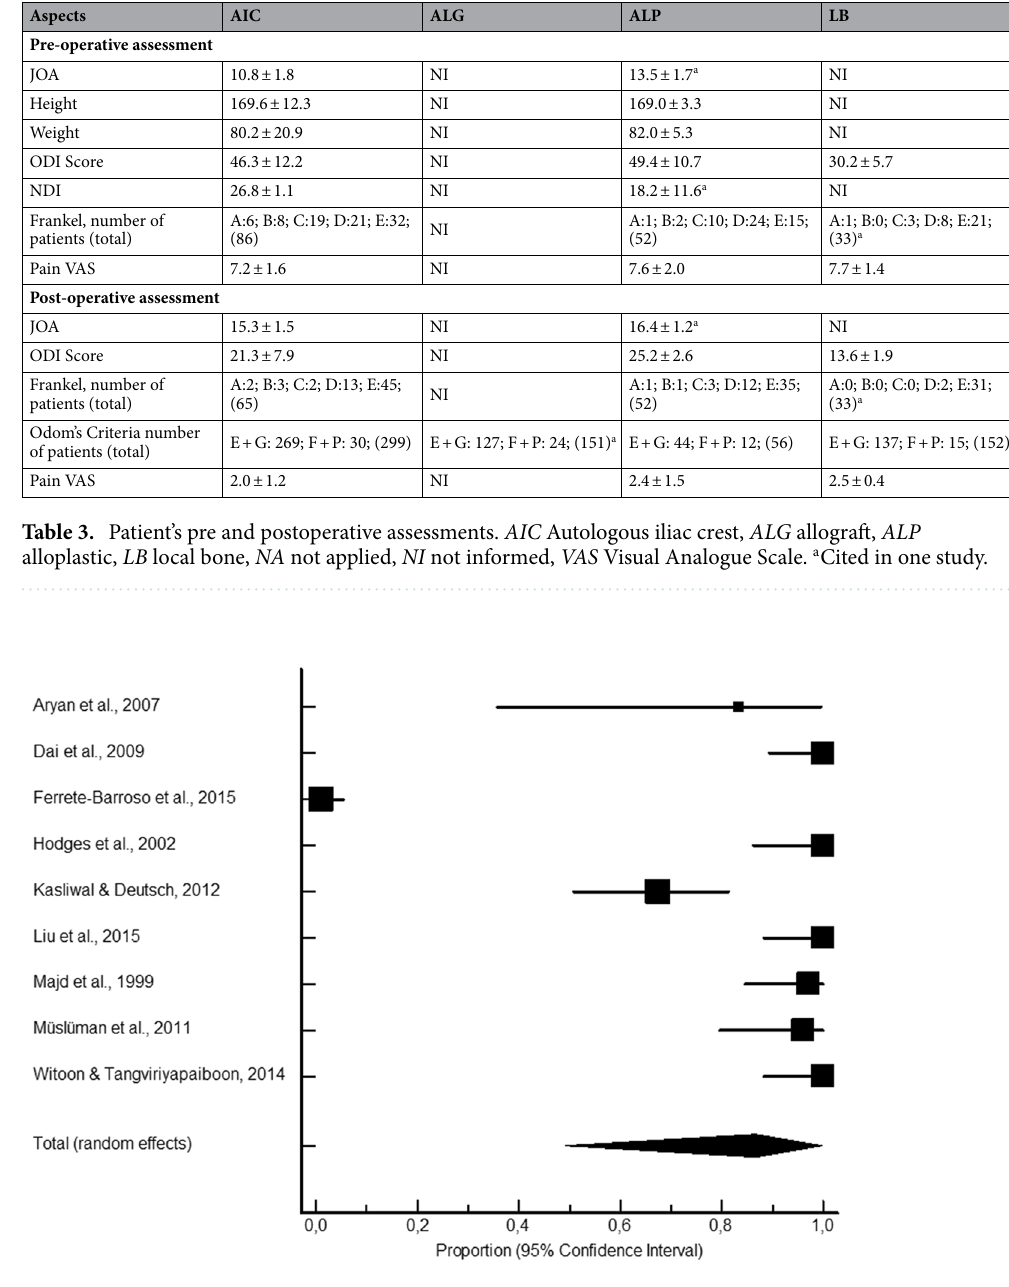
Figure 1. Local bone pooled proportional rate for spinal